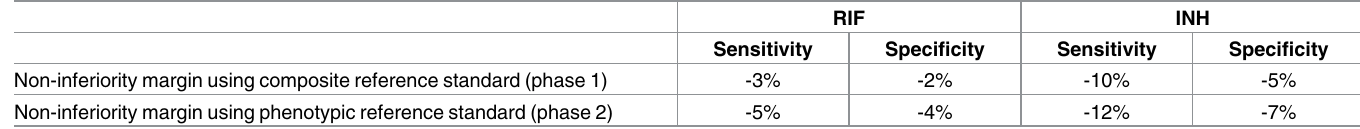
Table 1. Non-inferiority margins for each accuracycomparison between the YD and Hain V1 line probe assays.